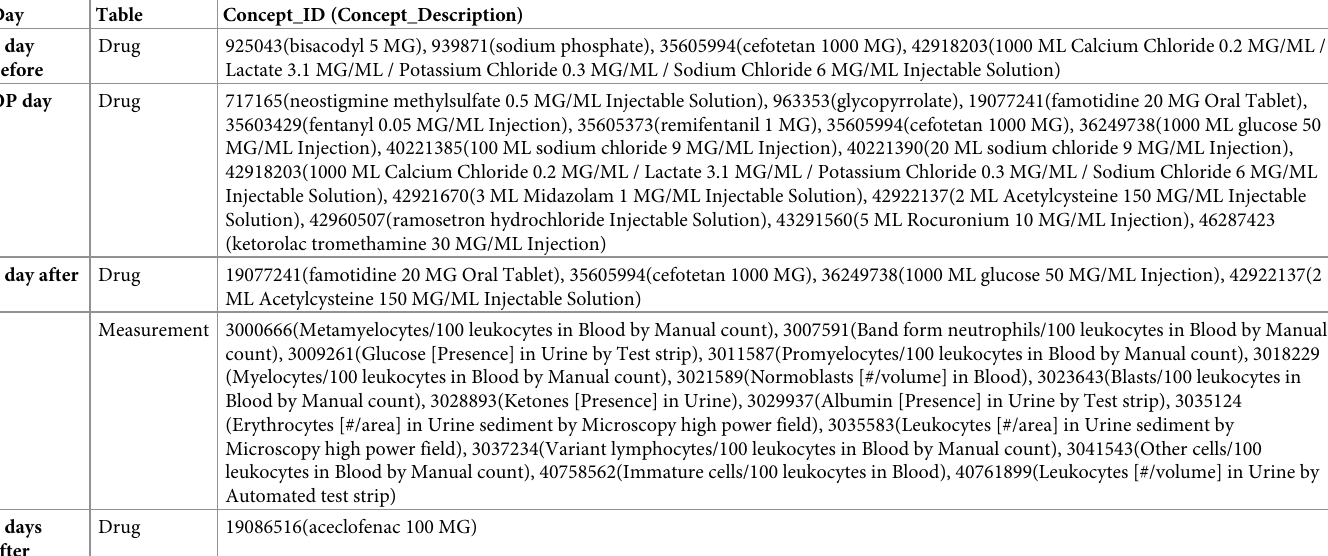
Table 6. Details of the derived CP by order day. Day Concept_ID